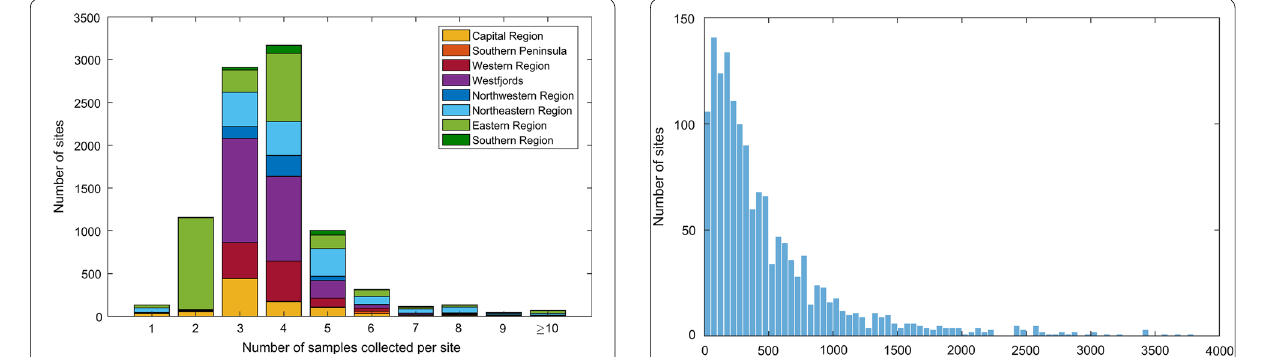
Fig. 9 Histogram of samples collected per site. Distribution of number of samples collected per site, coloured by geographic region (legend inset)